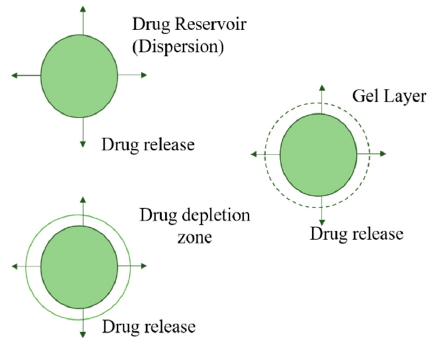
Figure 16. A polymer matrix diffusion-controlled system.